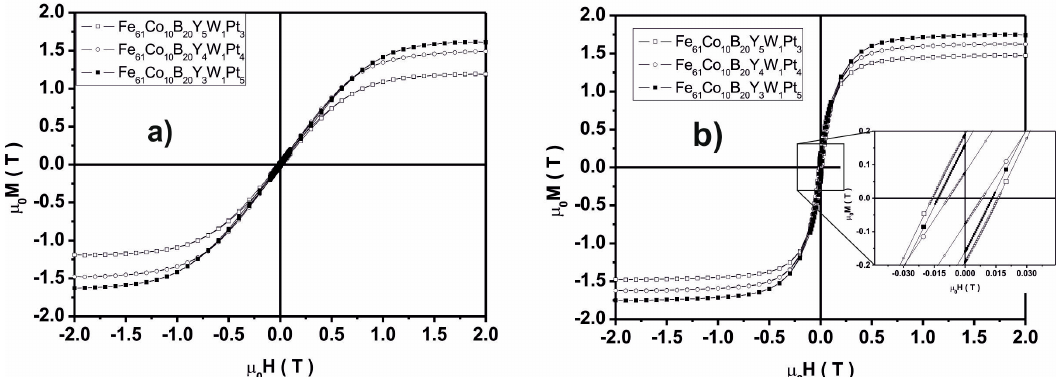
Figure7. Statichysteresisloopsfortheinvestigatedsamples, measuredforthedirectionofmagnetization ( a ) perpendicular, ( b ) parallel to the sample surface.